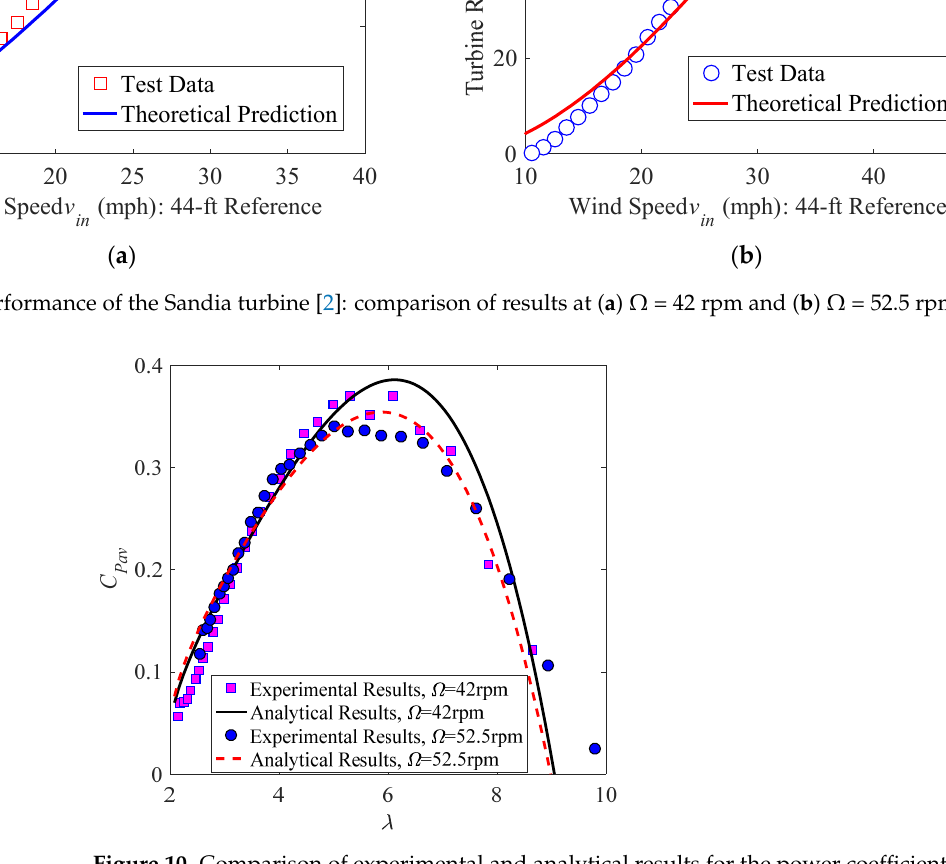
Figure 10. Comparison of experimental and analytical results for the power coefficient.